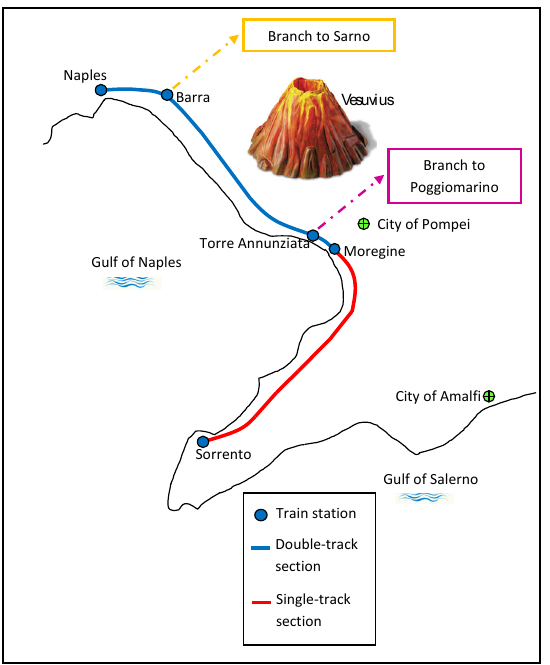
Fig. 1. General framework of the Naples–Sorrento regional rail